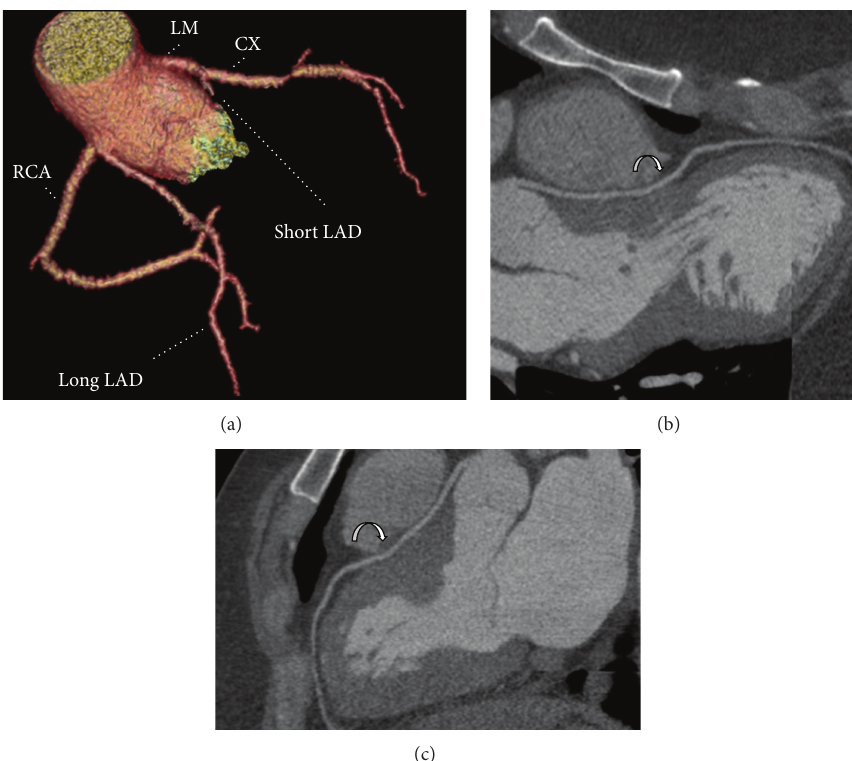
Figure 1: (a) 3D volume-rendered CTA images of the coronary circulation (LM: left main coronary artery; CX: circumflex branch; LAD: left anterior descending artery; RCA: right coronary artery). (b) and (c): Curved multiplanar reconstruction CTA images of the long LAD arising from the right coronary cusp with hammock-like descending curvature (curved arrows) consistent with a transseptal course.